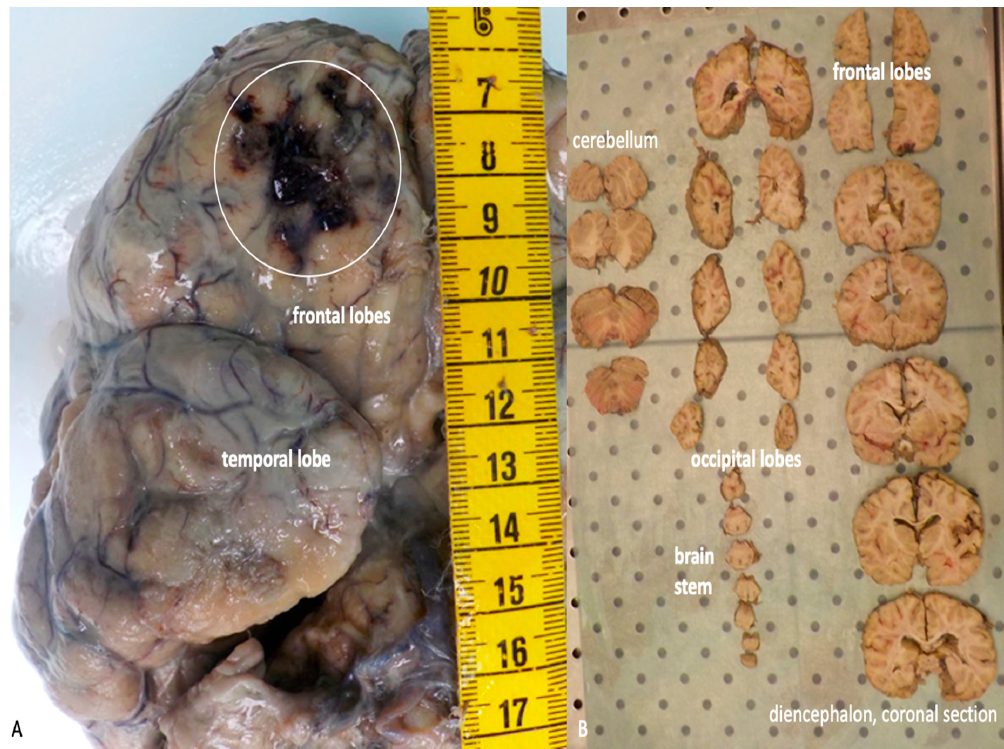
Figure 5. ( A ) Macroscopic examination of the brain after formalin embedding. A traumatic contusion area at the level of the frontal lobe is evident (white circle). ( B ) Serial coronal sections of the brain. Table 2. Semi-quantitative evaluation of immunohistochemical reaction to specific markers in brain samples with correlate